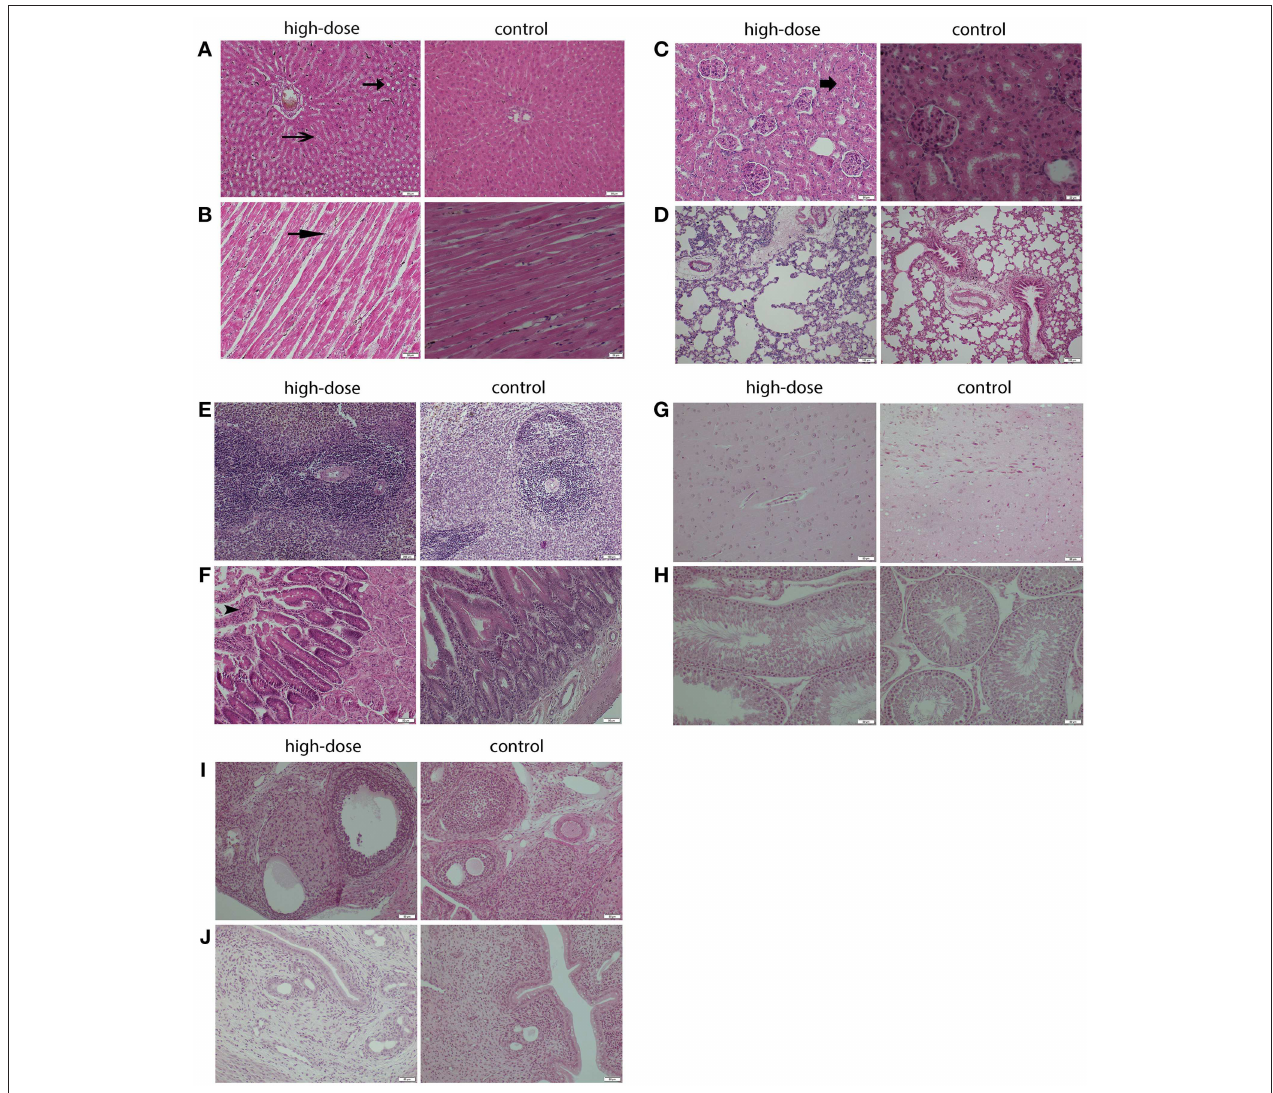
FIGURE 2 | Histopathological analyses of the liver (A) and heart (B) in high-dose rats with/without oxyclozanide treatment. The arrows indicate that there are granular degeneration and fatty degeneration of liver cells in the liver (A) and myocardial fiber degeneration in the heart (B) . Histopathological analyses of the kidney (C) and lung (D) in high-dose rats with/without oxyclozanide treatment. The arrows indicate that there are granular degeneration in renal tubular epithelial cells in the kidney (C) and normal in the lung (D) . Histopathological analyses of the spleen (E) and duodenum (F) in high-dose rats with/without oxyclozanide treatment. The arrows indicate that they are normal in the spleen (E) and catarrhal enteritis in the duodenum (F) . Histopathological analyses of the brain (G) and testis (H) in high-dose rats with/without oxyclozanide treatment. The arrows indicate that it is normal in the brain (G) and testis (H) . Histopathological analyses of the ovary (I) and uterus (J) in high-dose rats with/without oxyclozanide treatment. The arrows indicate that it is normal in the ovary (I) and uterus (J)